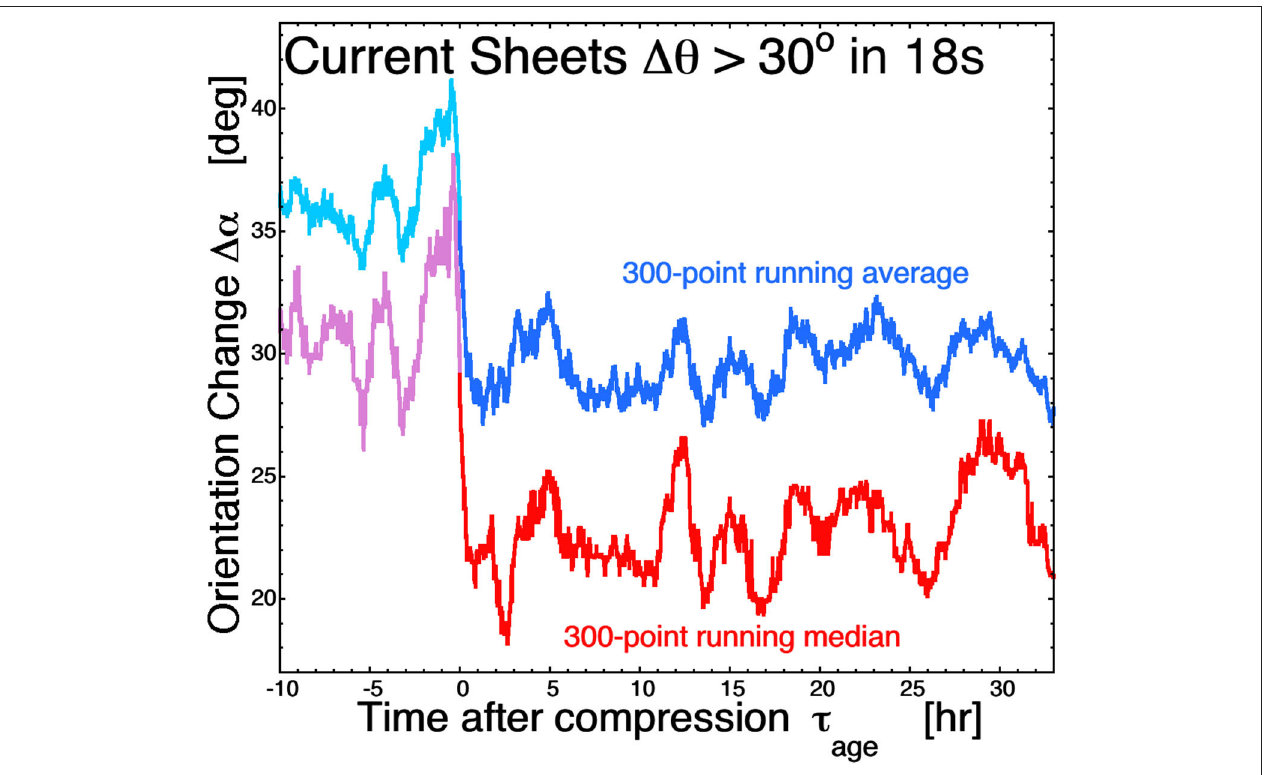
FIGURE 4 | The curves of Figure 3b are replotted as a function of the time since each element of plasma was shock-compressed.